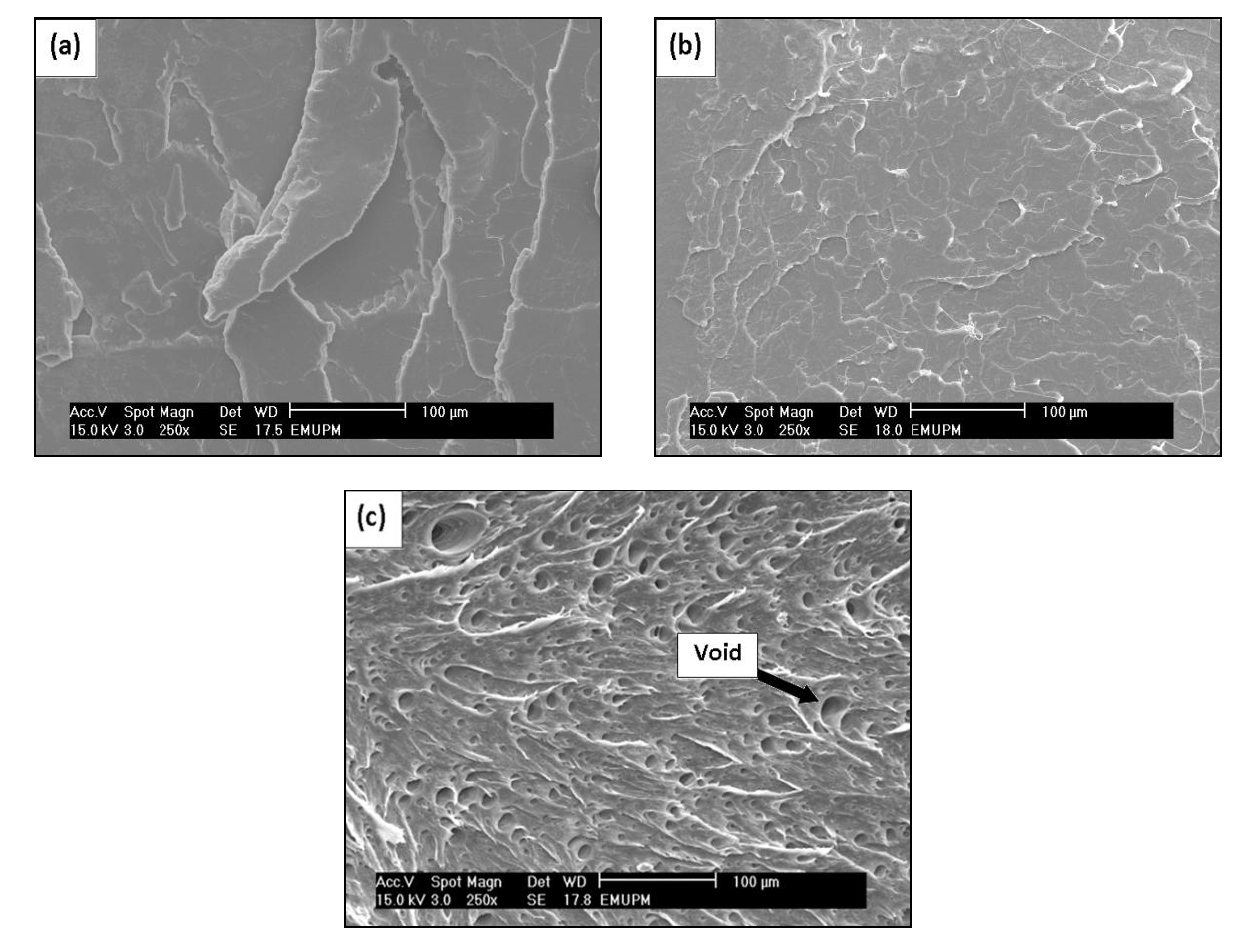
Figure 5. SEM images of ( a ) neat PLA, ( b ) PLA/1 wt% EPO and ( c ) PLA/5 wt% EPO